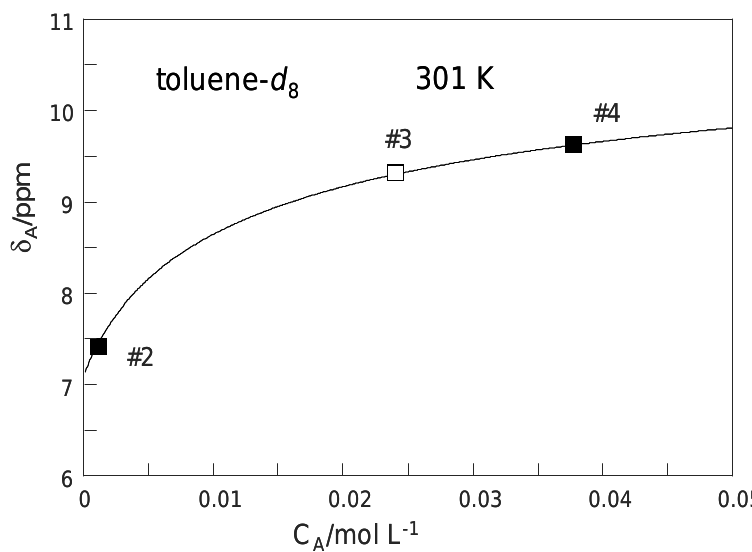
line. The abscissa value then provided the unknown concentration of C sample #3. This value is almost equal to the value of K as expected for a similar number of TMRA molecules present as monomers and in dimers.